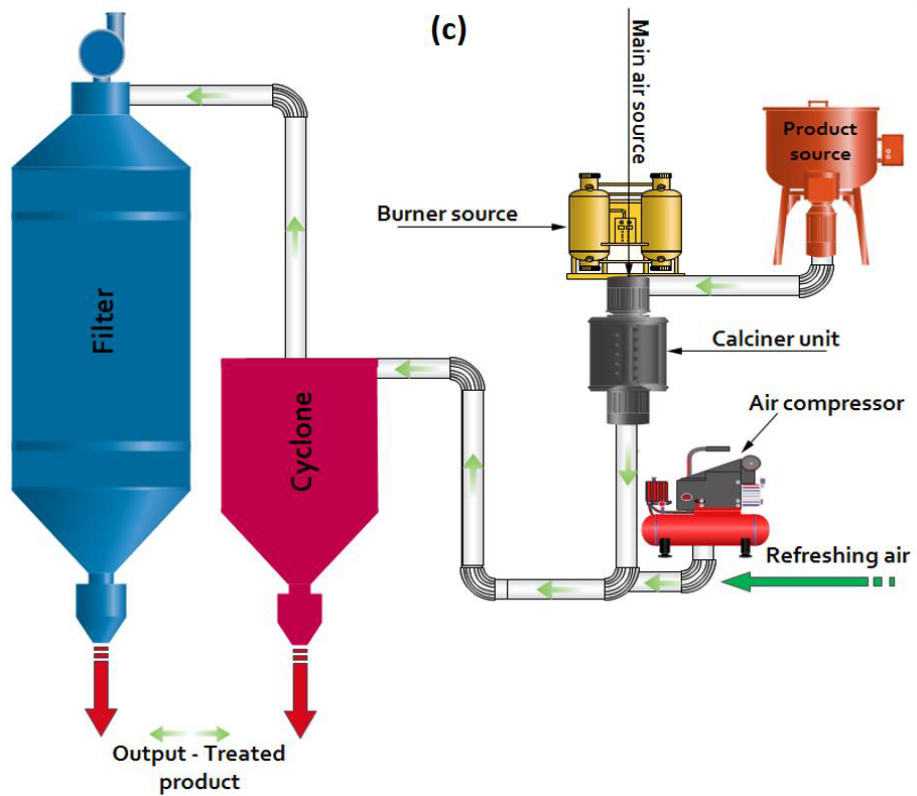
Figure 2. ( a ) Flash calciner chamber; ( b ) Semi-mobile flash tower [22]; ( c ) Pilot installation.